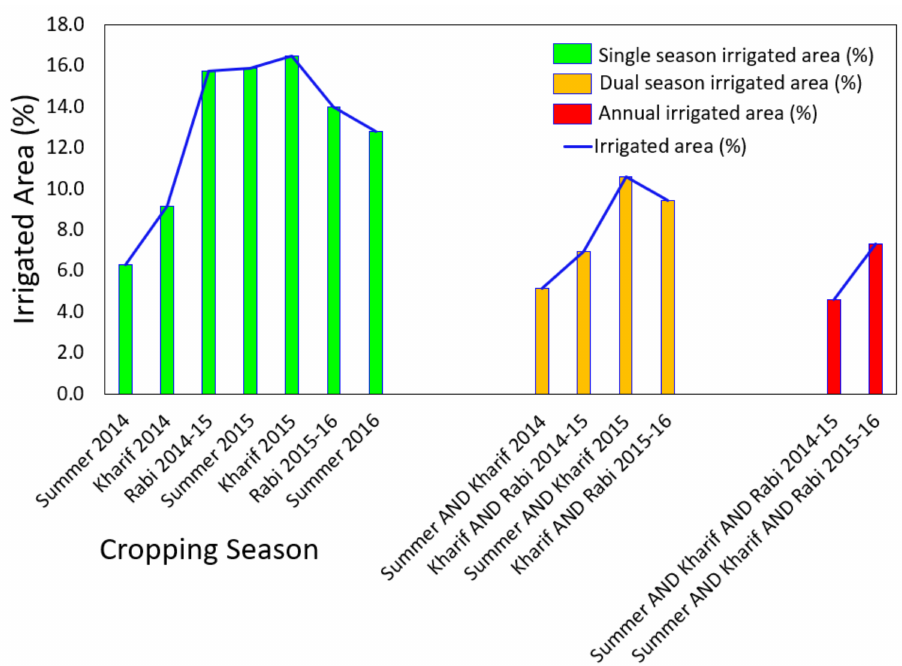
Figure 13. Representation of irrigated area percentage during various single cropping seasons, dual cropping seasons, and all cropping seasons.